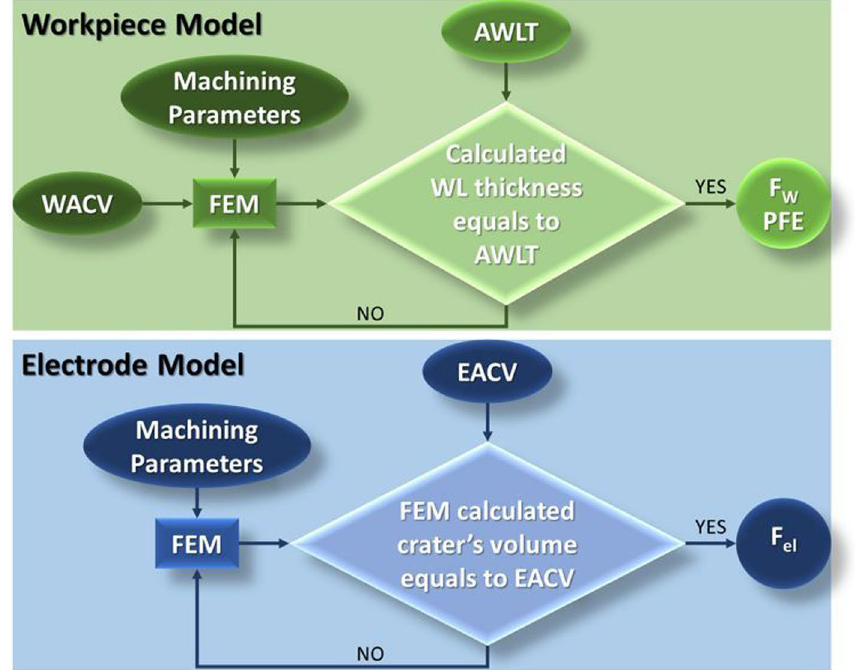
Figure 3. Flow chart of the reverse engineering